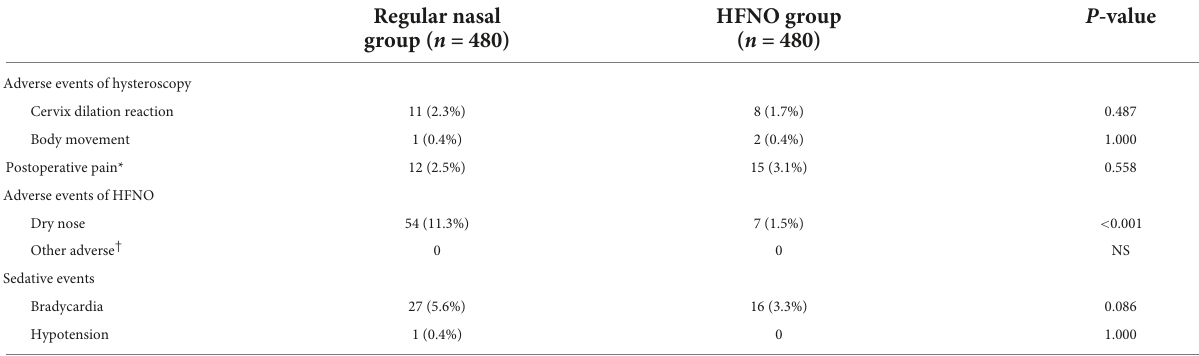
TABLE 3 The adverse events of hysteroscopy, HFNO, and